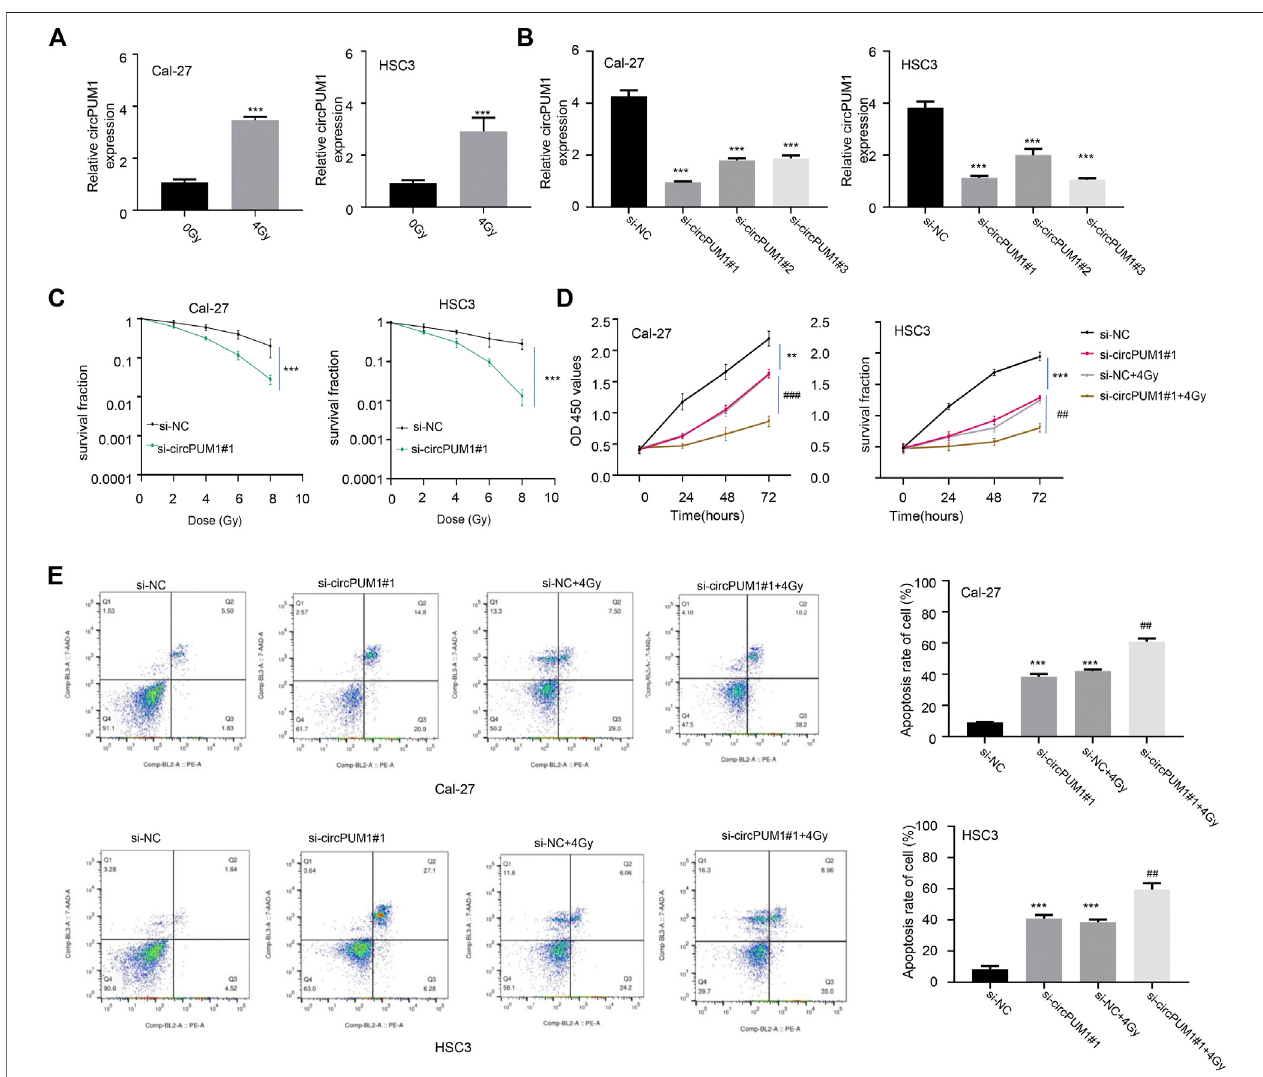
FIGURE2 | QRT-PCR wasused todetect the expression ofCircPUM1 in Cal-27 and hsc3 cells (A) ; expression of CircPUM1 in different groups ofOSCC cells (B) ; colony survival fraction of Cal-27 and hsc3 cells in different groups under different radiation doses (C) ; optical absorption values of Cal-27 and hsc3 cells in different groupsat450 nmatdifferenttimeperiodsweremeasured (D) ;apoptosiswasobservedindifferentgroupsofCal-27andhsc3cells (E) . p < 0.01( pp )and p < 0.001( ppp